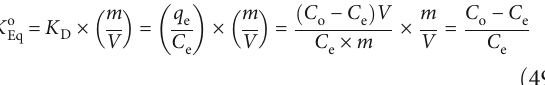
Table 6: Thermodynamic parameters of the dye adsorption process (Figure 2) calculated based on K (mg/g) vs. C (mg/L) When q When q e e